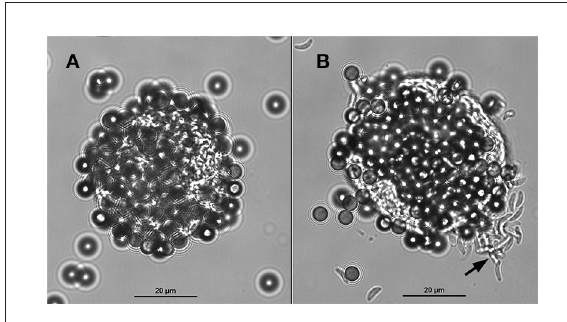
FIGURE3 A tissue cyst of Toxoplasma gondii derived from mouse brain bound to magnetic beads containing the monoclonal antibody K8/15-15. (A) The beads cover most of the tissue cyst surface. (B) The same tissue cyst shown in A was mechanically ruptured by pushing the coverslip against the glass slide; note that some beads were detached from the cyst wall and numerous bradyzoites (black arrow) were released from the tissue cyst.